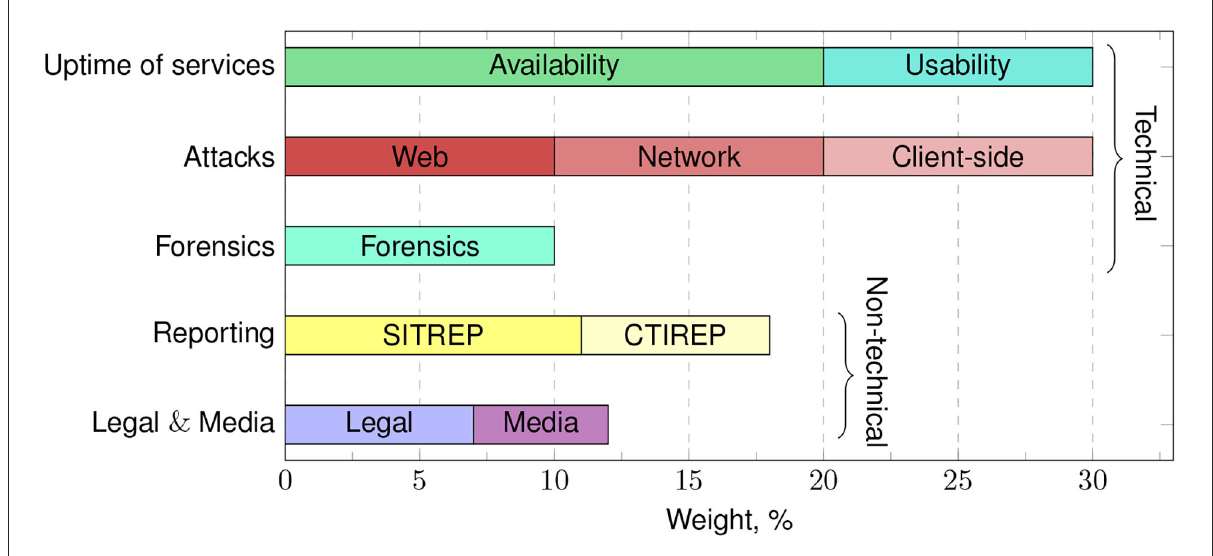
FIGURE2 Weights of scoring categories.